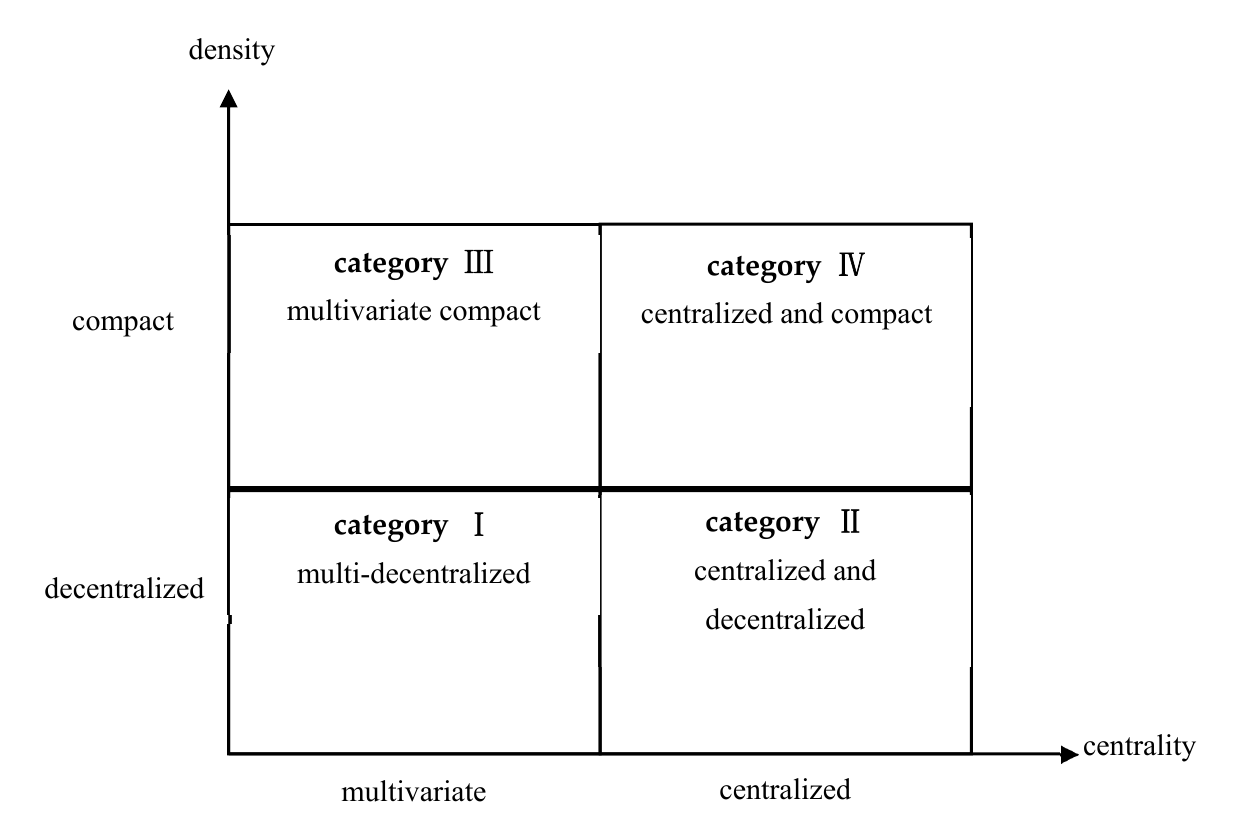
Figure 3. Types of institutional network relations in the public crisis governance system. Table 3. Institutional characteristics of the inter-agency network of the Chinese public crisis governance system. During